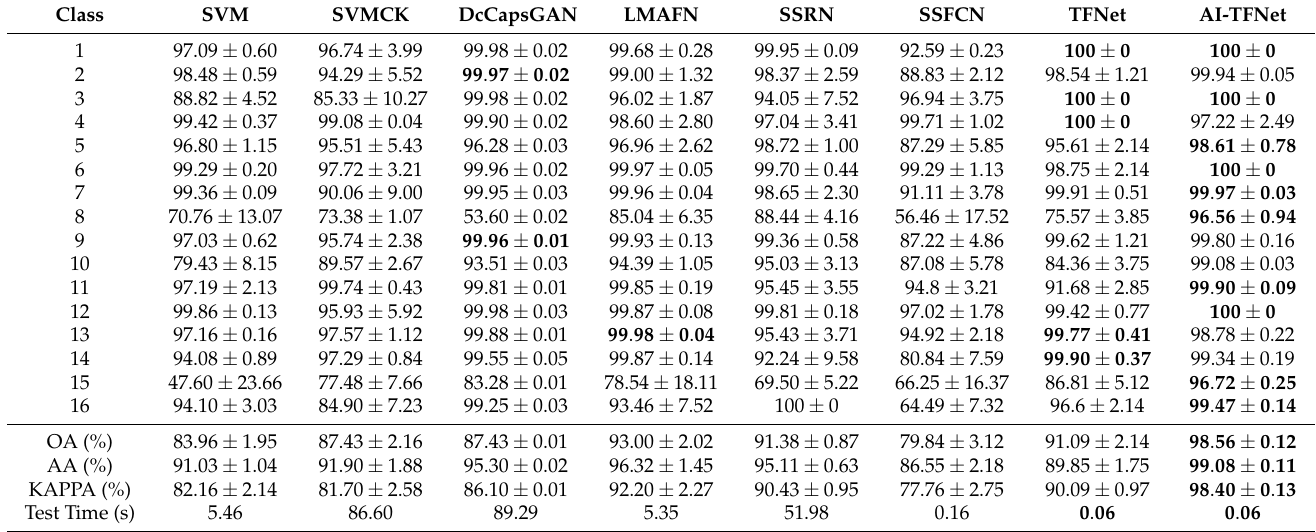
Table 9. Classification accuracy of different methods on the Salinas dataset with 10 labeled samples for 10 random iterations. (The best results in each row are represented in bold).